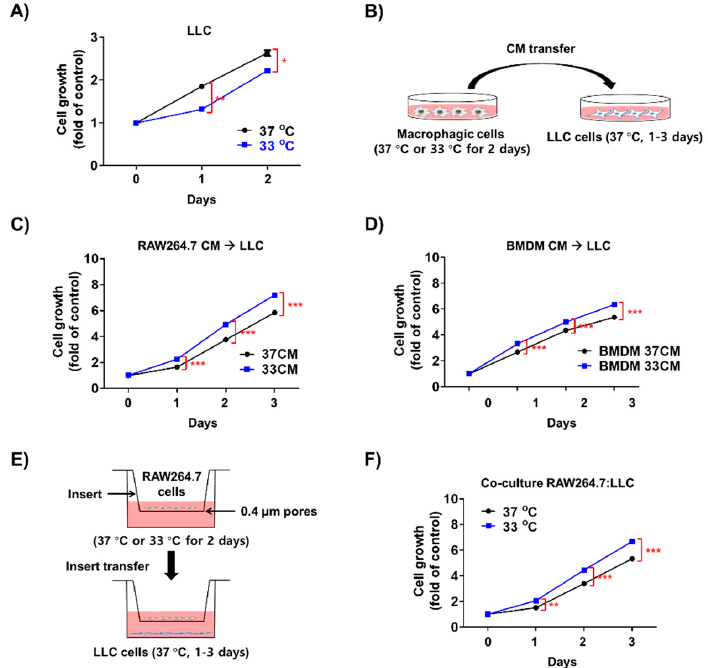
Figure 3. The proliferation of LLC cells was enhanced by macrophages exposed to low temperature. ( A ) LLC cells were incubated at 33 or 37 °C for 48 h. Cell growth was measured by MTT assay. ( B ) A schematic representation of serum-transfer experiments. Culture media from RAW264.7 cells or BMDMs incubated at 33 or 37 °C for 48 h were transferred to LLC cells, which were then cultured 37 °C for 72 h. ( C , D ) The growth of LLC cells in the presence of conditioned media (CM) from RAW264.7 cells ( C ) or bone marrow-derived macrophages (BMDMs) ( D ) was measured by MTT assay for 72 h. ( E ) Schematic presentation of the co-culture of RAW264.7 cells and LLC cells. Co-culture was performed by seeding RAW264.7 cells in the upper chamber and plating LLC cells in the lower chamber. ( F ) The growth of LLC cells co-cultured with RAW264.7 cells was examined by MTT assay. Data are expressed as the mean ± SD. * p < 0.05, ** p < 0.01, and *** p < 0.001 compared to the control